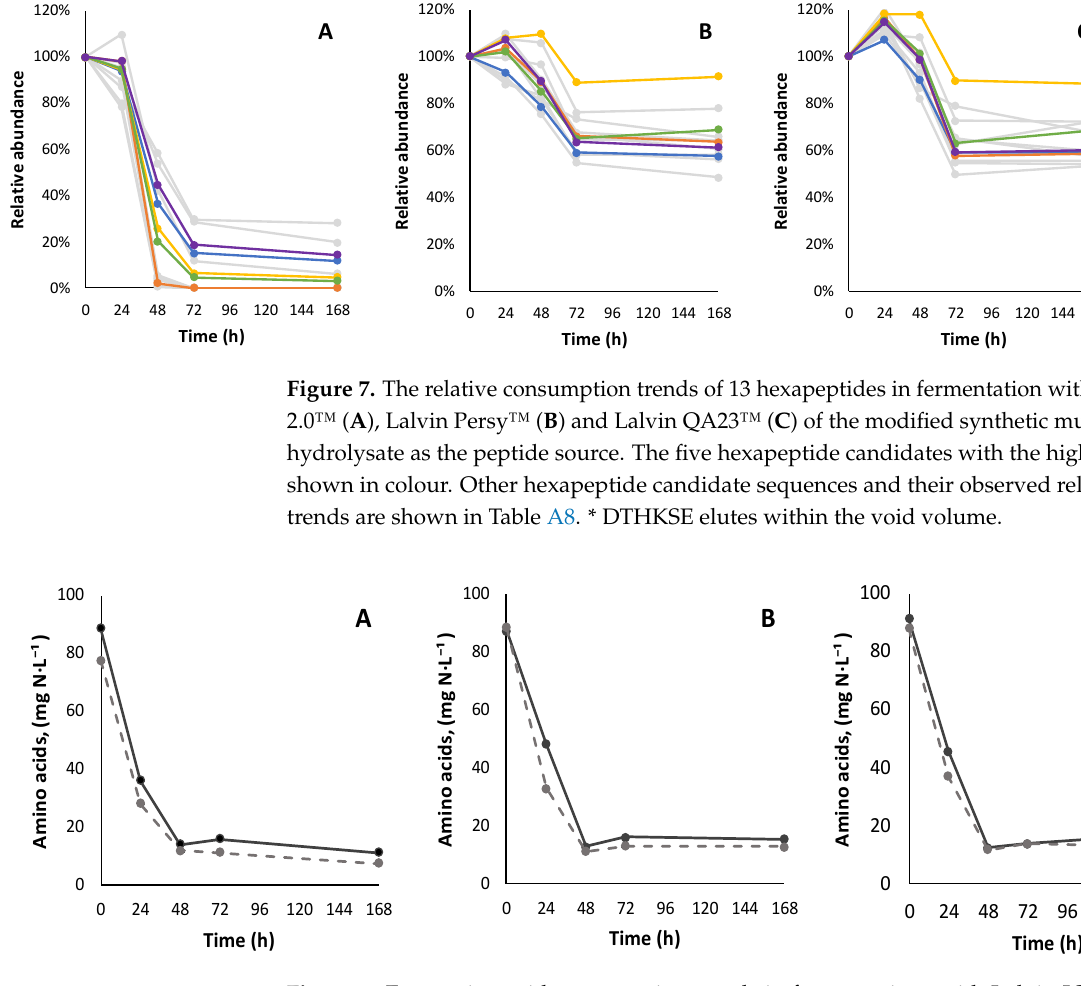
Figure 8. Free amino acid consumption trends in fermentations with Lalvin ICV Opale 2.0™ ( A ), Lalvin Persy™ ( B ) and Lalvin QA23™ ( C ) of the modified synthetic must with (solid line) and without (dashed line) added BSA hydrolysate as the peptide source.